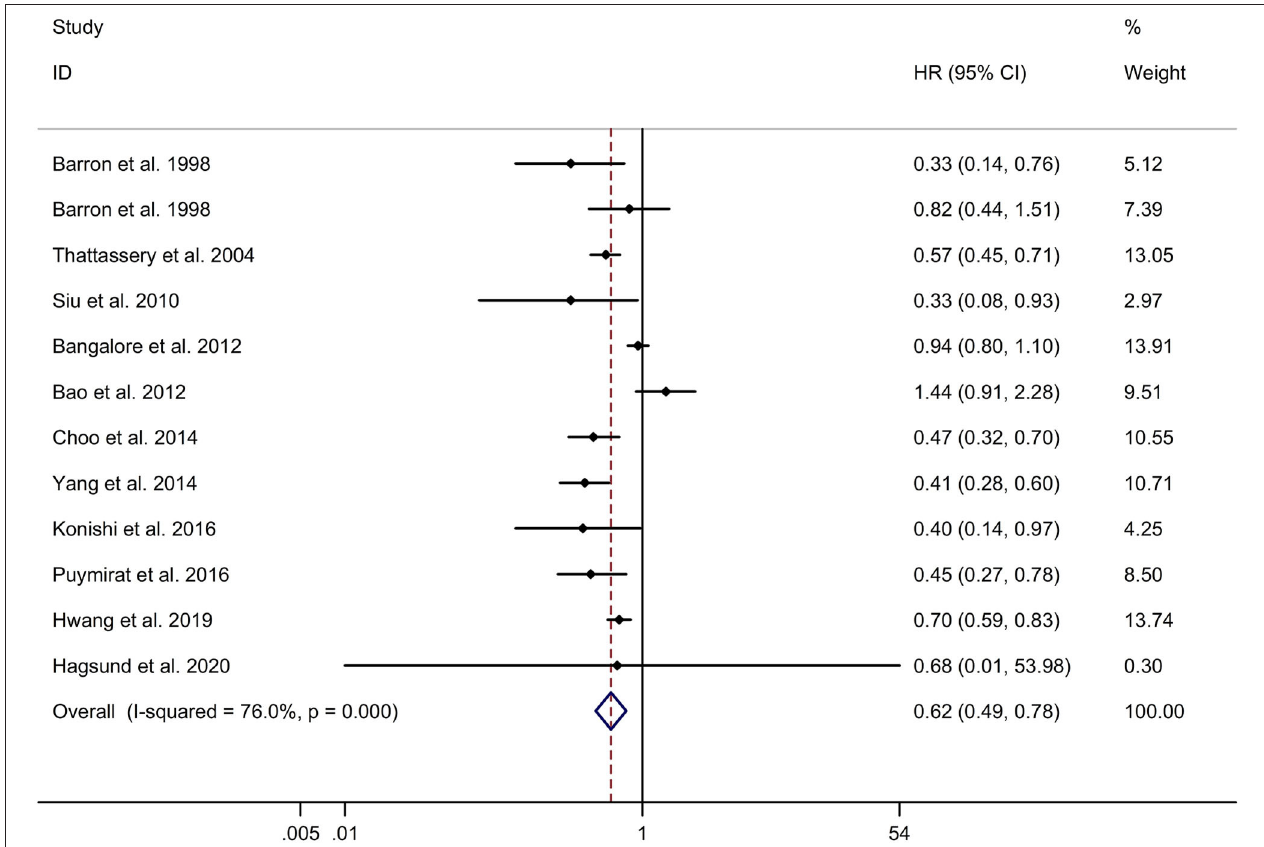
FIGURE 2 | Forest plots exploring the long-term effect of β -blocker use on cardiovascular mortality in patients after MI. CIs, confidence intervals; HRs, hazard ratios; MI, myocardial infarction.